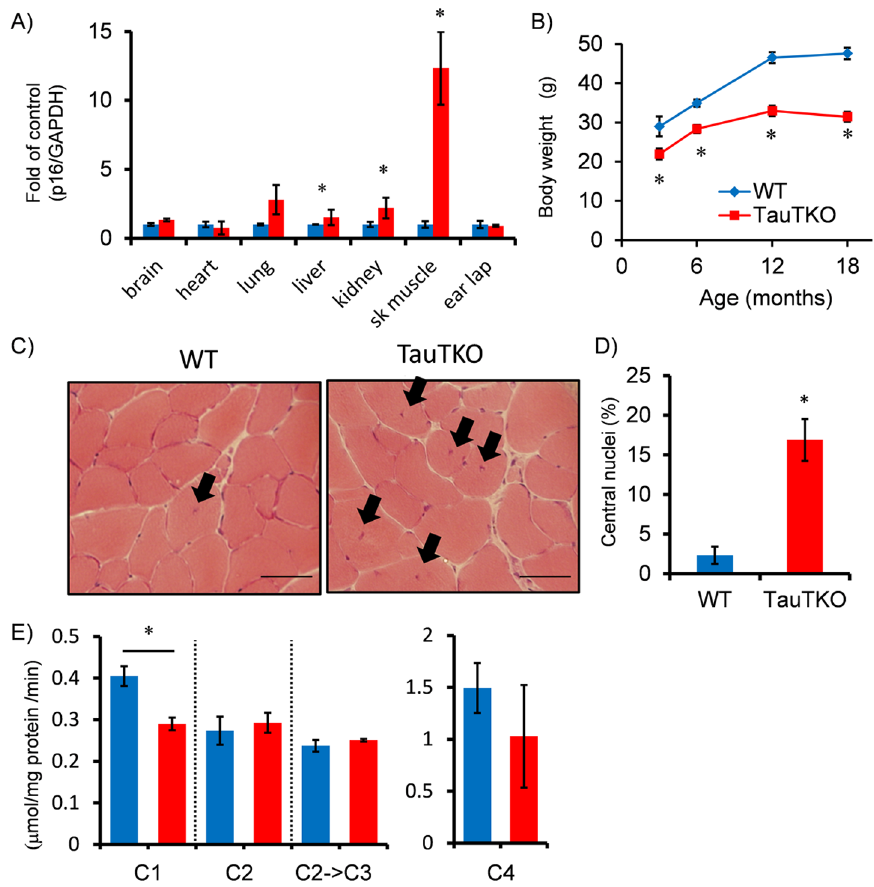
Figure 2. Accelerated aging in TauTKO muscle. A) mRNA level of the senescence marker, p16INK4A, was quantified in several tissues of old TauTKO and WT mice by real-time RT-PCR. The marker is severely increased in old TauTKO muscle. n=4–7. B) Body weight of TauTKO mouse is consistently lower than that of the WT mouse. n=6–12. C), D) Histological analysis of tibial anterior muscles shows an induction of myotubes with central nuclei indicated by arrows in old TauTKO muscle. The ratio of myotubes with central nuclei to total myotubes is significantly higher in old TauTKO than WT. n=6. Scale bar=50 m m. E) The assays for electron transport chain complex reveal that activity of mitochondrial complex1 is decreased in old TauTKO muscle. C1–4; Complex 1–4. n=4–5. *;p , 0.05.